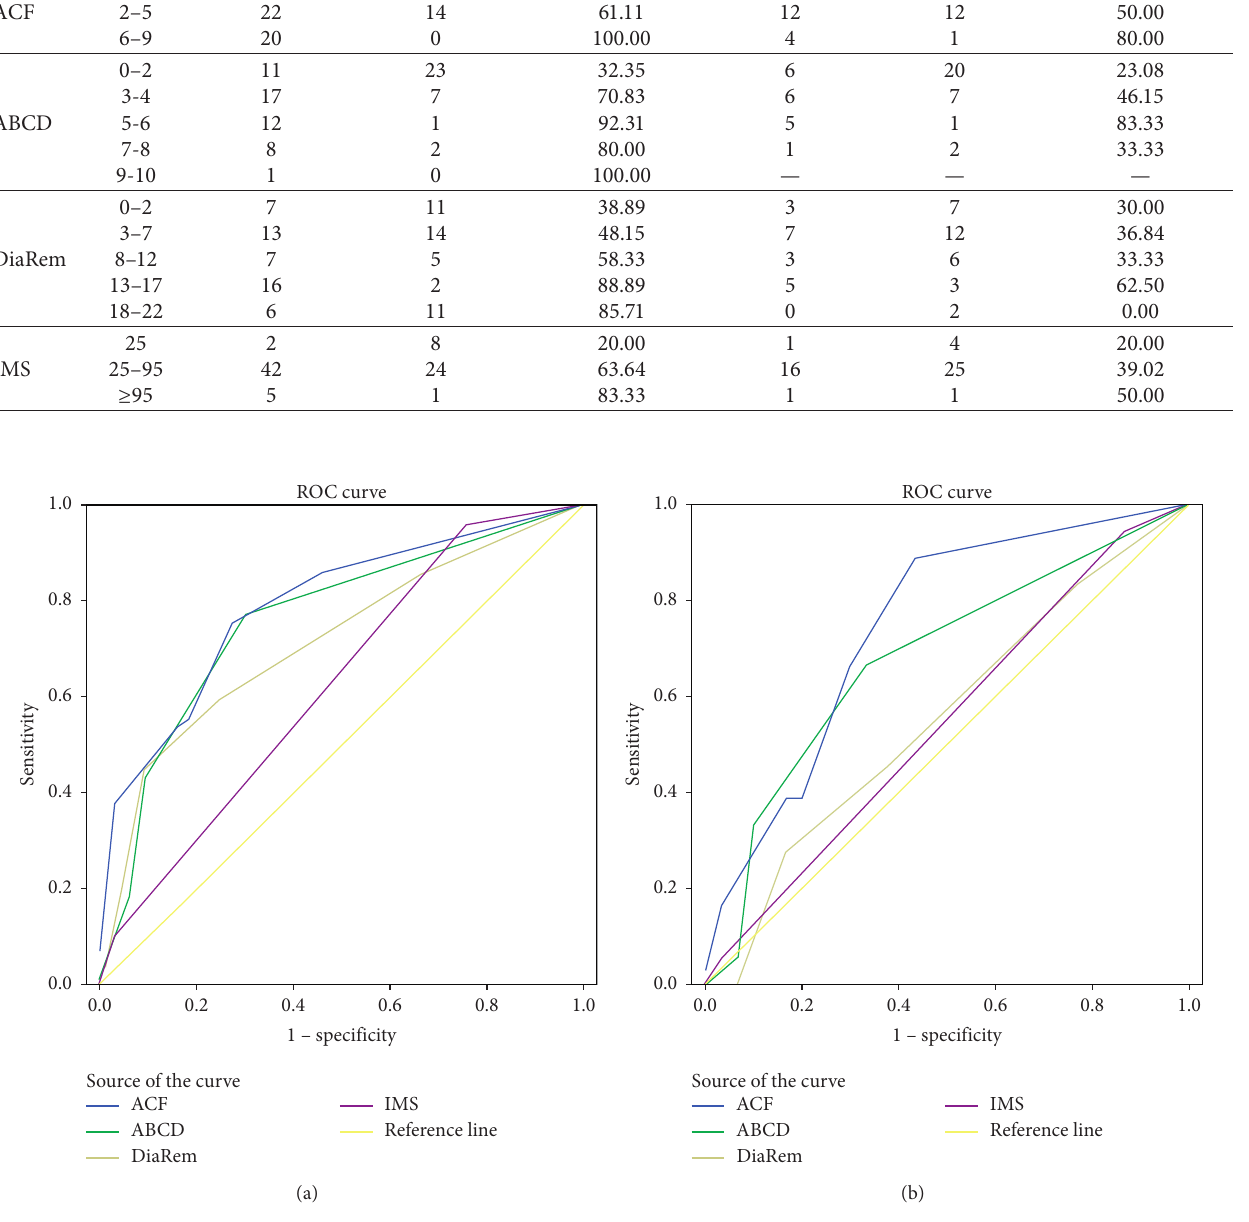
Figure 2: ROC curve analysis of ACF, ABCD, Diarem, and IMS scores. (a) In the short-term T2D remission prediction, the area under the ROC curves using the ACF score (the blue line) is 0.793, P < 0 . 001 ∗ ; the area under the ROC curves using the ABCD score (the green line) is 0.762, P < 0 . 001 ∗ ; the area under the ROC curves using the DiaRem score (the brown line) is 0.715, P � 0 . 001 ∗ ; and the area under the ROC curves using the IMS score (the purple line) is 0.625, P � 0 . 056. (b) In the long-term T2D remission prediction, the area under the ROC curves using the ACF score (the blue line) is 0.748, P � 0 . 004 ∗ ; the area under the ROC curves using the ABCD score (the green line) is 0.681, P � 0 . 038 ∗ ; the area under the ROC curves using the DiaRem score (the brown line) is 0.556, P � 0 . 086; and the area under the ROC curves using the IMS score (the purple line) is 0.547, P � 0 .